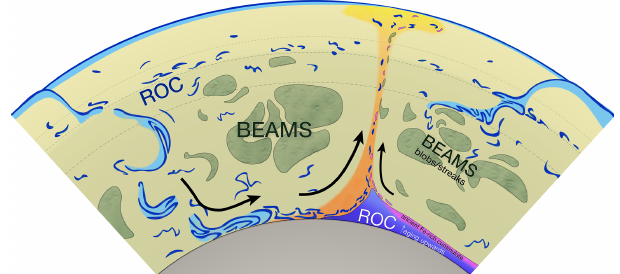
Figure 9. Sketch of our proposed style of present-day mantle het- erogeneity in the Earth. Recycled crustal material (ROC, dark blue) is present throughout the mantle as marble cake streaks, with en- hancement in the mantle transition zone (between 410 and 660km depth). Moreover, the dense ROC material settles at the CMB to form thermochemical piles. Any ancient basal layer may be pre- served within these piles, here proposed to be on the roof of the piles as predicted by our models (see Fig. 8). Finally, primordial (Mg, Fe)SiO 3 -enriched material is preserved as blobs and streaks that reside in the mid-mantle (dark green) due to its intrinsic strength (BEAMS: bridgmanite-enriched ancient mantle structures, Ballmer et al.,